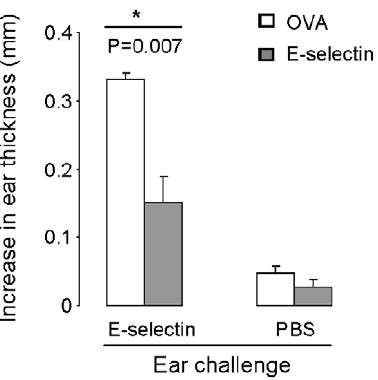
Figure 2. Intranasal delivery of E-selectin reduces swelling in a delayed type hypersensitivity reaction. 9 week old mice under- went one round (consisting of five intranasal administrations every other day) of 10 m l PBS containing either 5 m g OVA (white bars) or E- selectin (black bars). After sensitization and subsequent challenge with E-selectin, responses to E-selectin were significantly reduced in animals previously receiving E-selectin versus those receiving OVA intranasally (P=0.007). Swelling was not significantly different in the ears challenged only with PBS between the two treatment groups. N=5 mice per group, error bars represent